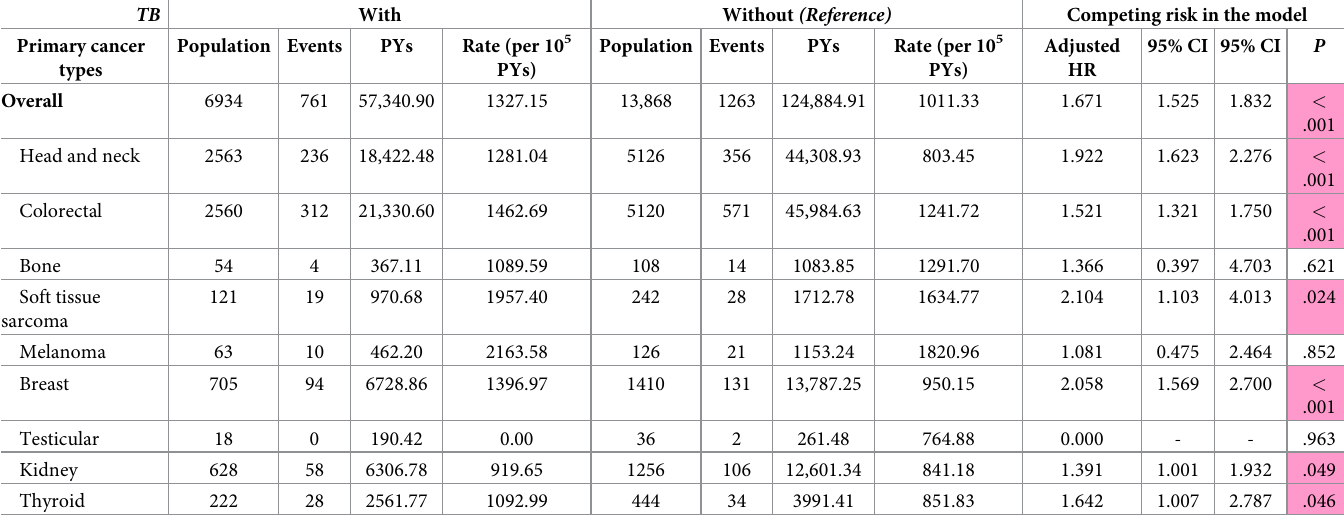
Table 4. Factors of secondary lung cancer among different primary cancer types using Cox regression and Fine & Gray’s competing risk model. TB With Without